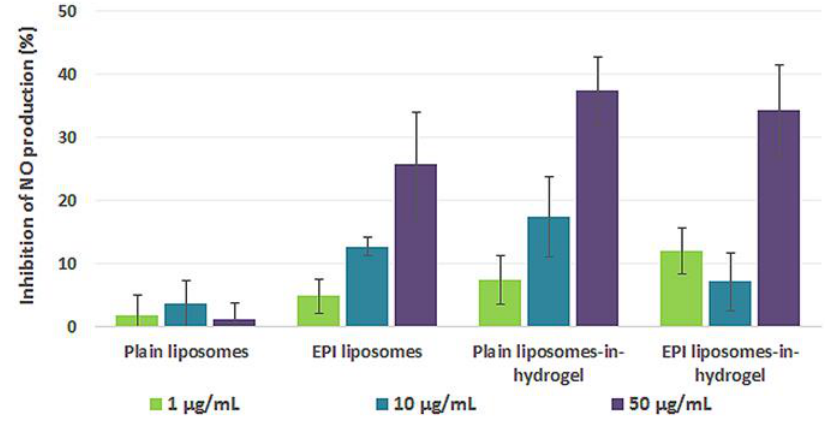
Figure 9. Inhibitory effect of EPI liposomes-in-hydrogel on NO production compared to plain liposomes-in-hydrogel. Results are expressed as percentage mean ± SD ( n = 3).